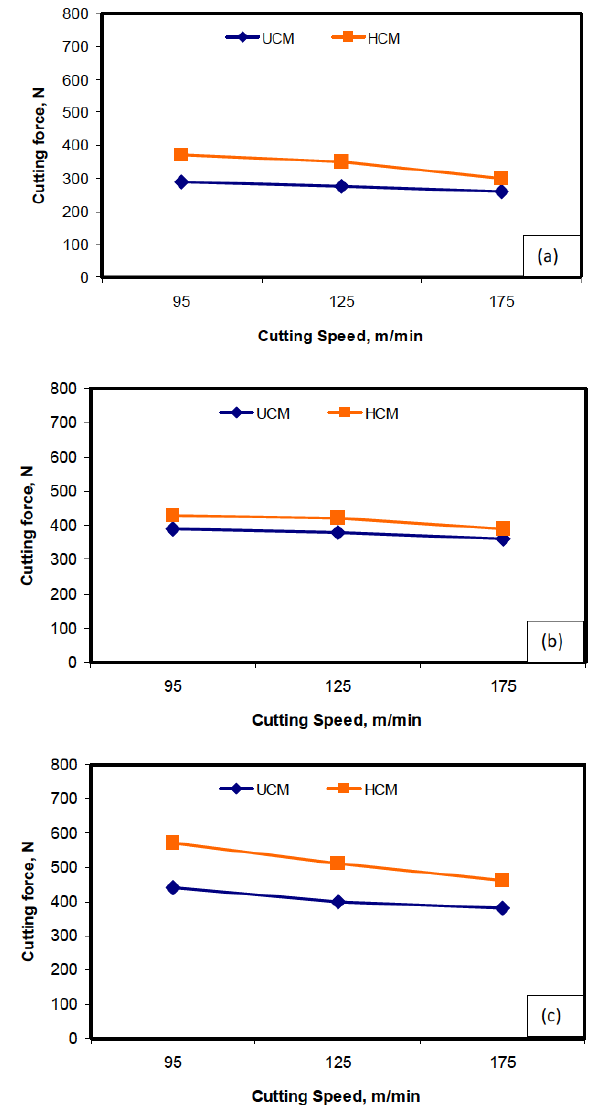
Figure 5: Variation of cutting force with increasing cutting speed (a) feed 0.05 mm/rev, depth of cut 0.25 mm (b) feed 0.1 mm/rev, depth of cut 0.25 mm (c) feed 0.15 mm/rev, depth of cut 0.25 mm